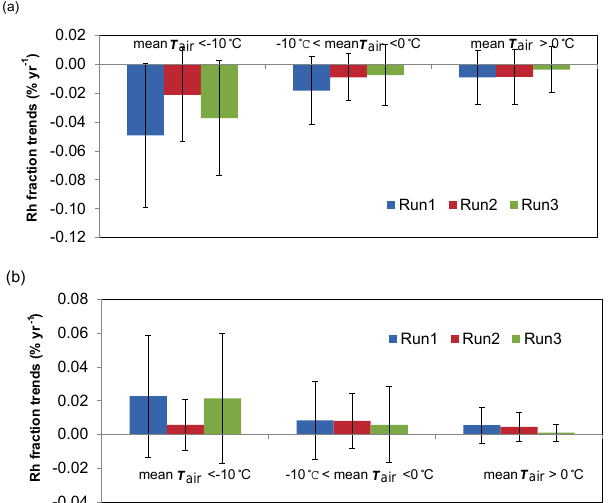
Figure 10. The zonal-average trends of warm-season (May– October) soil heterotrophic respiration ( R h ) contribution (i.e., R h fraction) from (a) surface litterfall (0–0.2m) and (b) deep (0.5– 3.0m) soil carbon pools for the three sensitivity experiments from 1982 to 2010. Run1 indicates model simulations based on varying temperature ( T ) and precipitation ( P ) inputs; Run2 indicates model simulations based on varying T inputs alone; and Run3 indicates model simulations based on varying P inputs